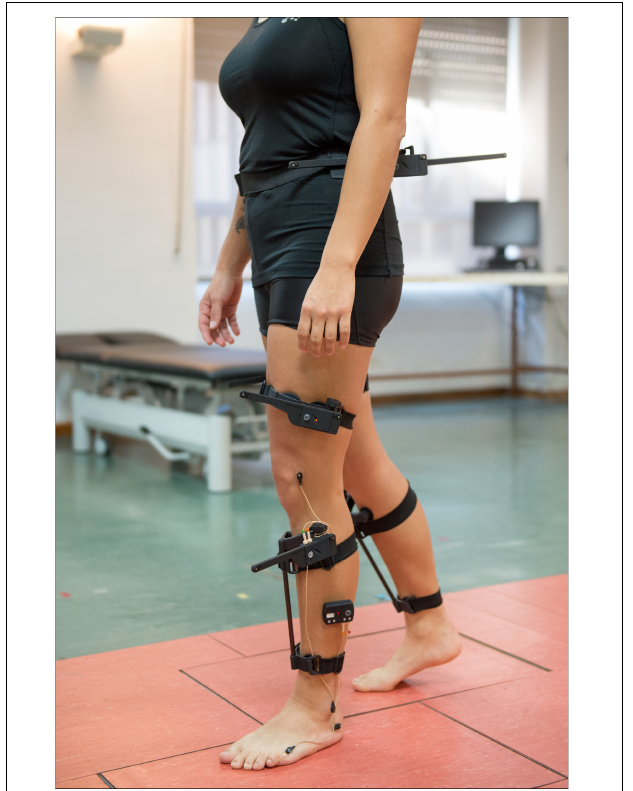
FIGURE 1 | Placement of the 22 active markers of Codamotion motion capture system on the lower limbs of an individual from HV group.